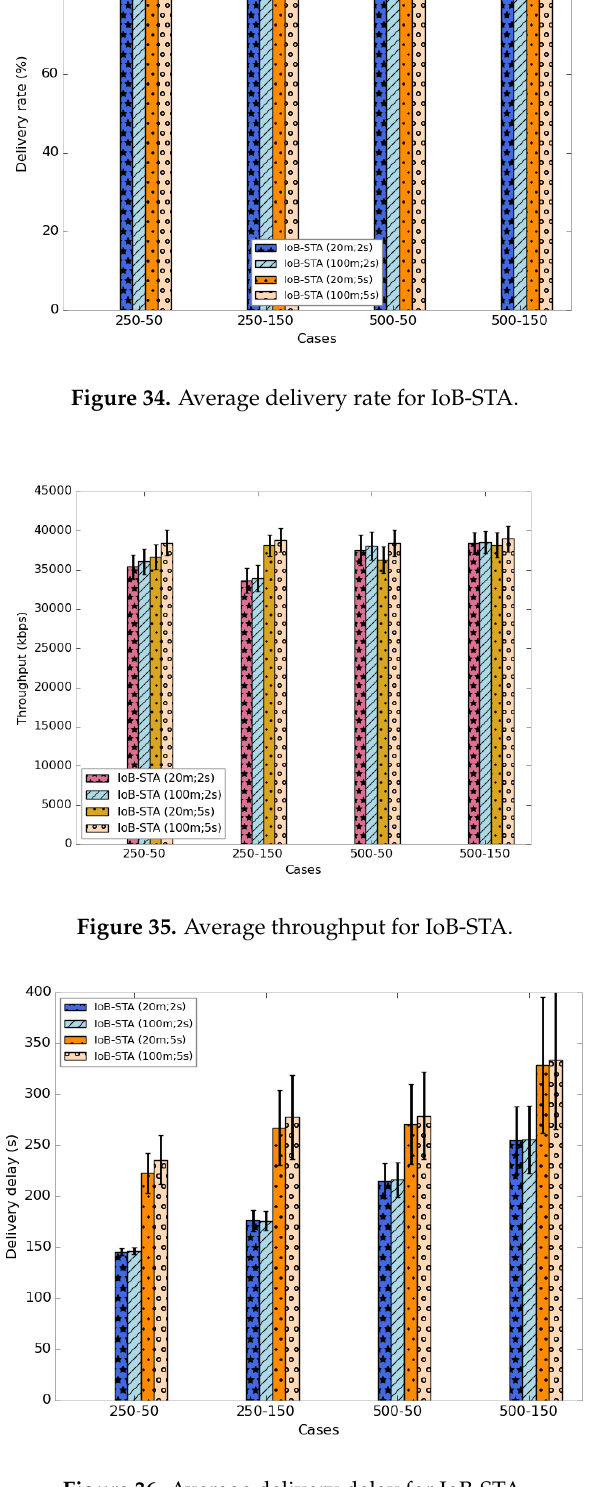
Figure 36. Average delivery delay for